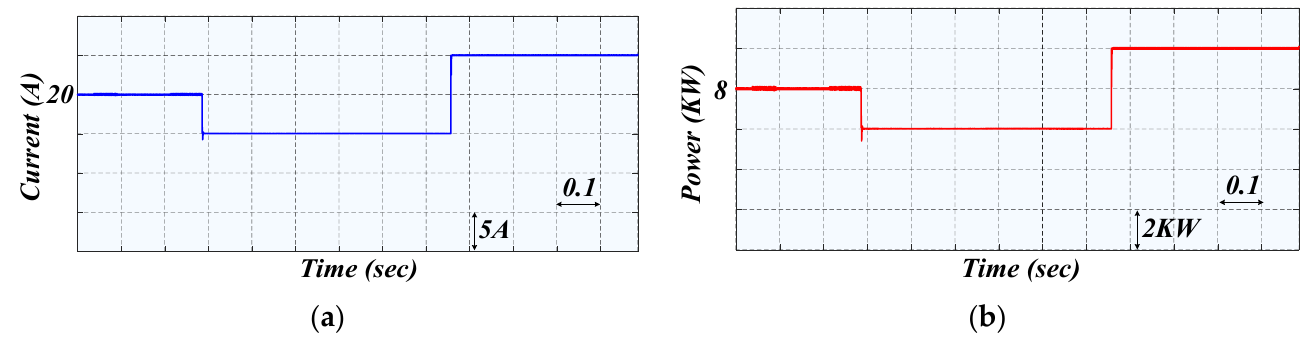
Figure 8. Real-time results for the power changes in the emergency charging mode in the pro- posed EPBC: ( a ) output current, ( b ) output power.